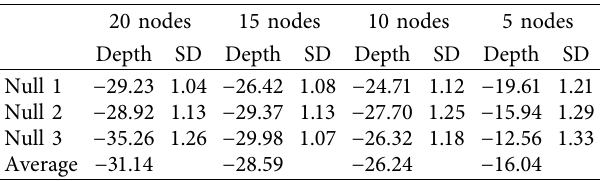
Figure 11: Azimuth cut of the normalized power pattern (at the elevation angle of 60 degrees) in a decibel Table 7: Null depth (in dB) corresponding to null steering using 20, 15, 10, and 5 nodes. SD denotes standard deviation.